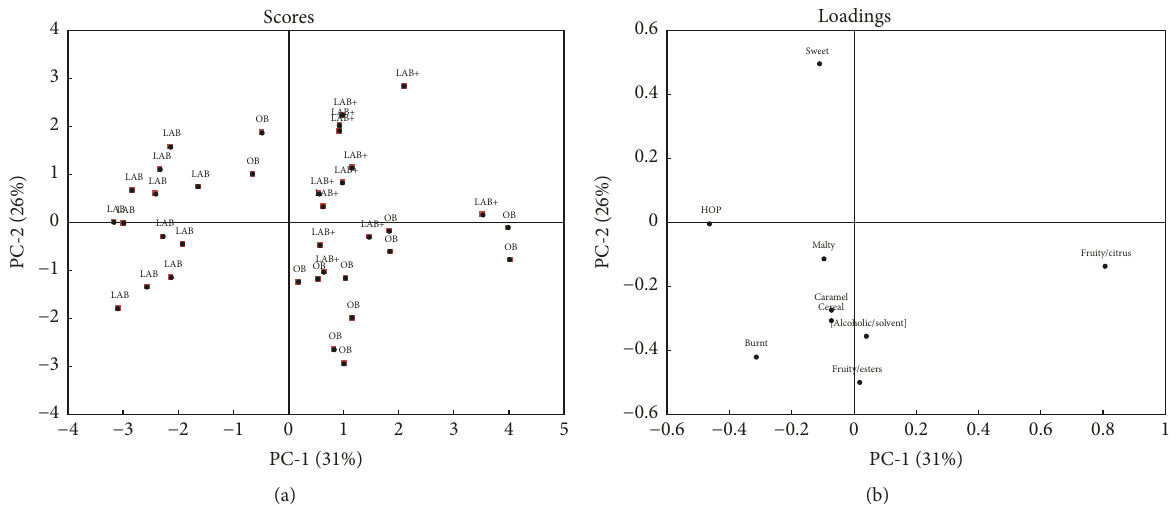
LAB sample, while “body,” “fruity/esters,” “fruity/citrus,” “malty,” and “alcohol” descriptors mostly correlated to the OB